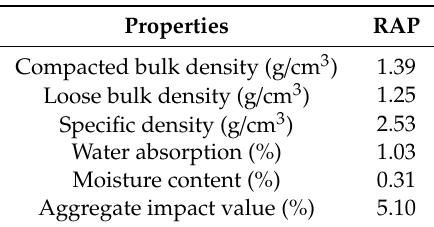
Table 1. Properties of RAP aggregate.